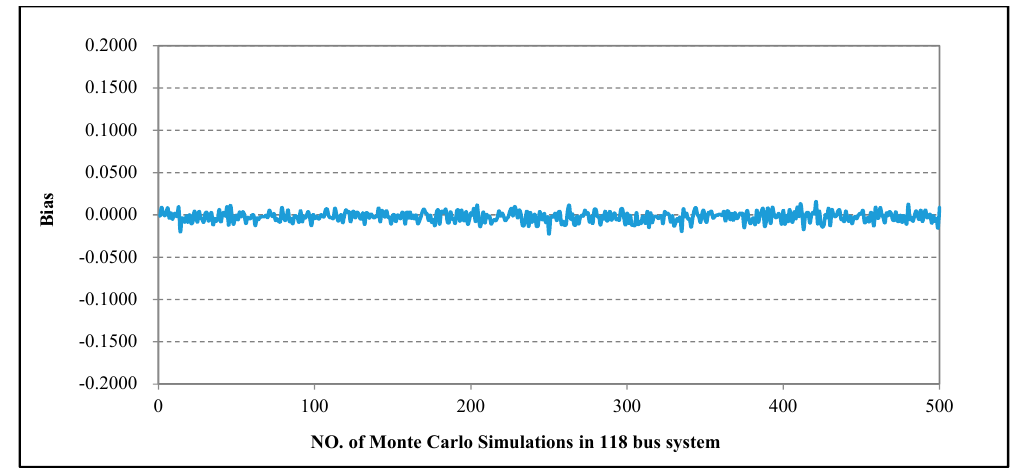
Figure 20. Bias analysis of proposed method in 118 bus system.